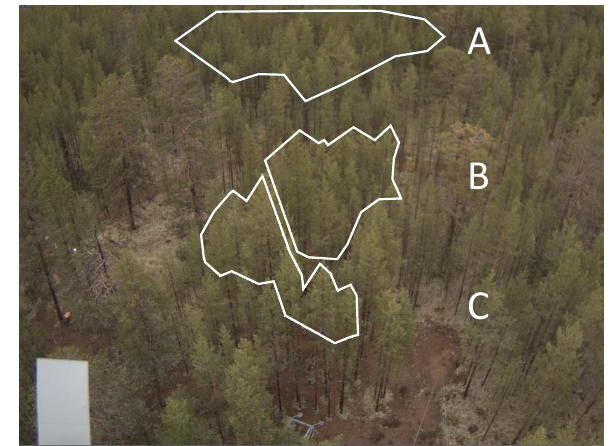
Figure 3. View from the pine forest canopy camera. The lines indi- cate three regions of